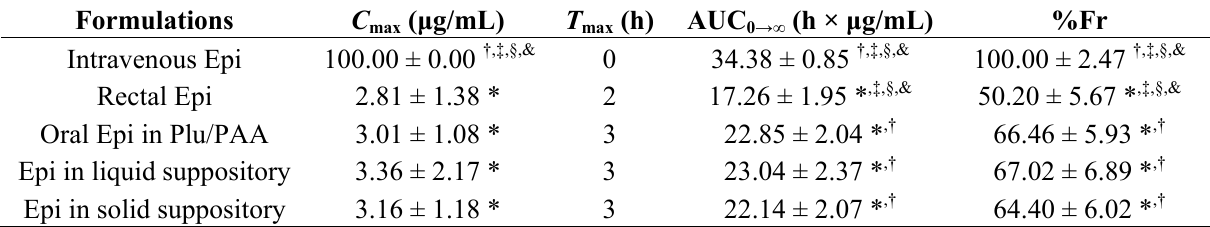
Table 3. The pharmacokinetic parameters of Epi administered in different formulations and routes into SD